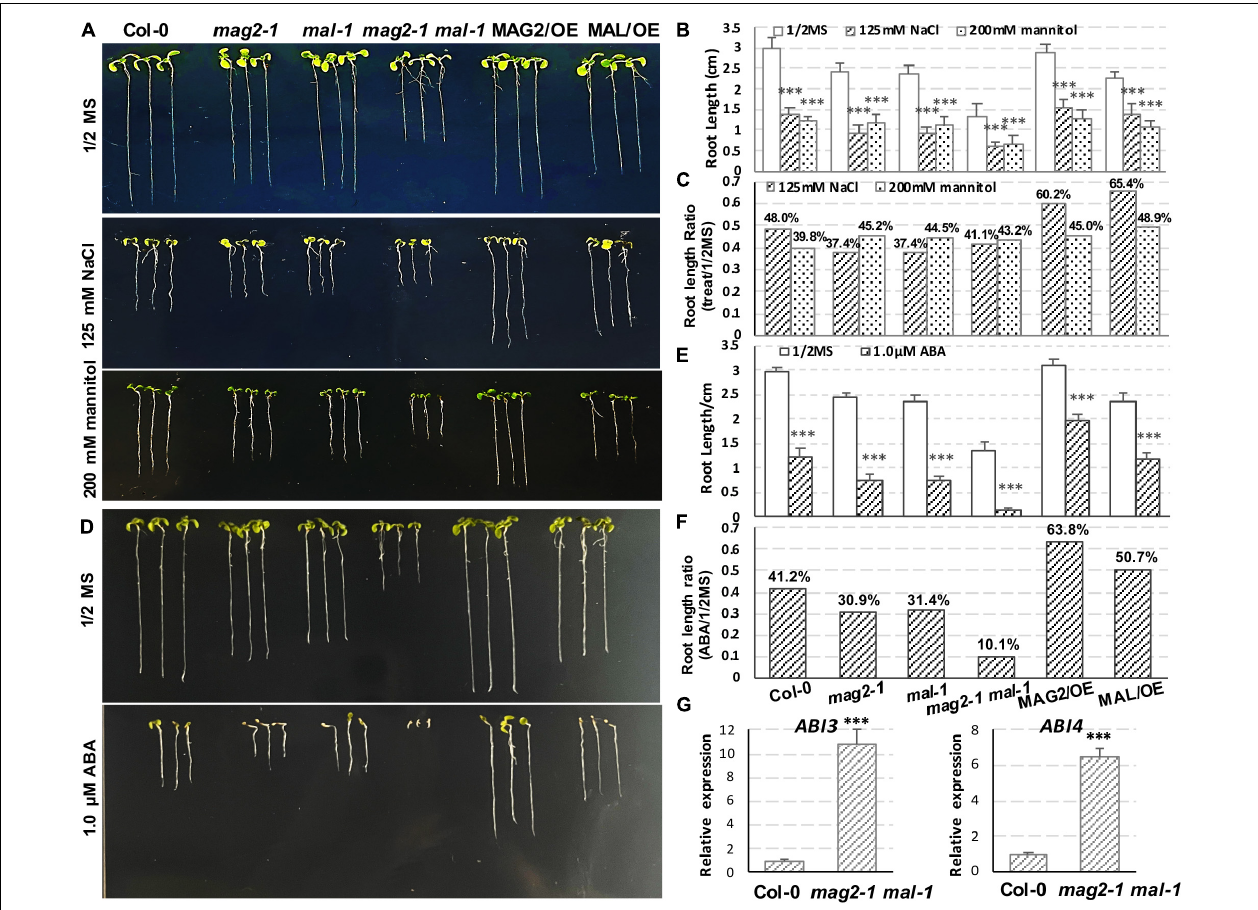
FIGURE 8 | MAG2 and MAL regulate plant stress response. (A) Seven-day-old seedlings grown in the 1/2 MS medium with 125 mM NaCl or 200 mM mannitol. (B) Statistics of root length in panel (A) . Values are means ± SD; n = 30, three repeats per sample. (C) Statistics of root length ratio before and after treatment in panel (C) . (D) Seven-day-old seedlings grown in the 1/2 MS medium with 1 µ M ABA. (E) Statistics of root length in panel (D) . Values are means ± SD; n = 30, three repeats per sample. (F) Statistics of root length ratio before and after treatment in panel (E) . (G) RT-qPCR determination of relative expression level of ABI3 and ABI4 . Two independent experiments per sample, and three repeats per experiment. ∗ p < 0.05, ∗∗ p < 0.01, and ∗∗∗ p < 0.001. Significance was evaluated by Student’s t -test using IBM SPSS Statistics